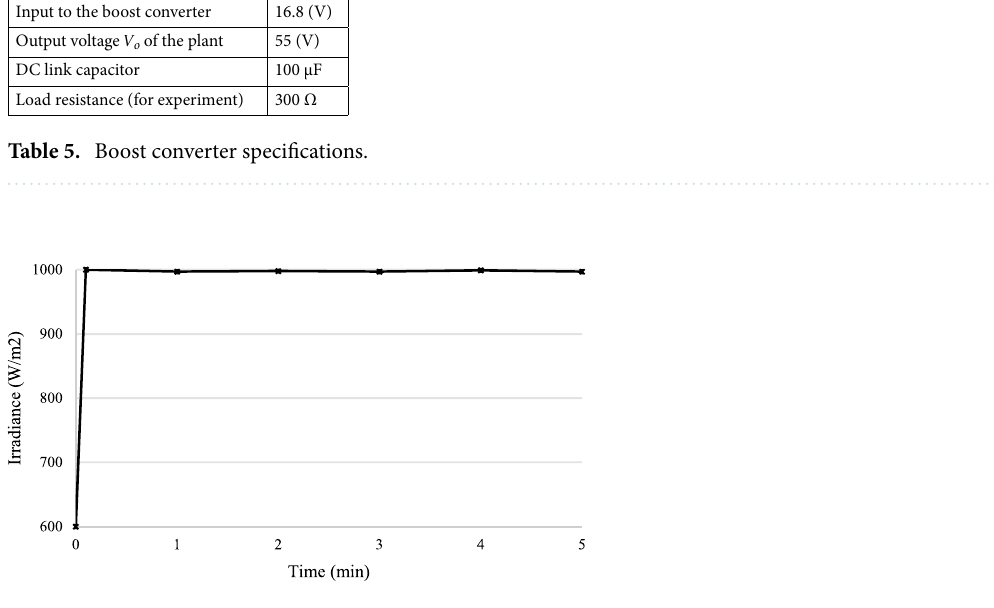
Figure 22. Measured uniform solar irradiance